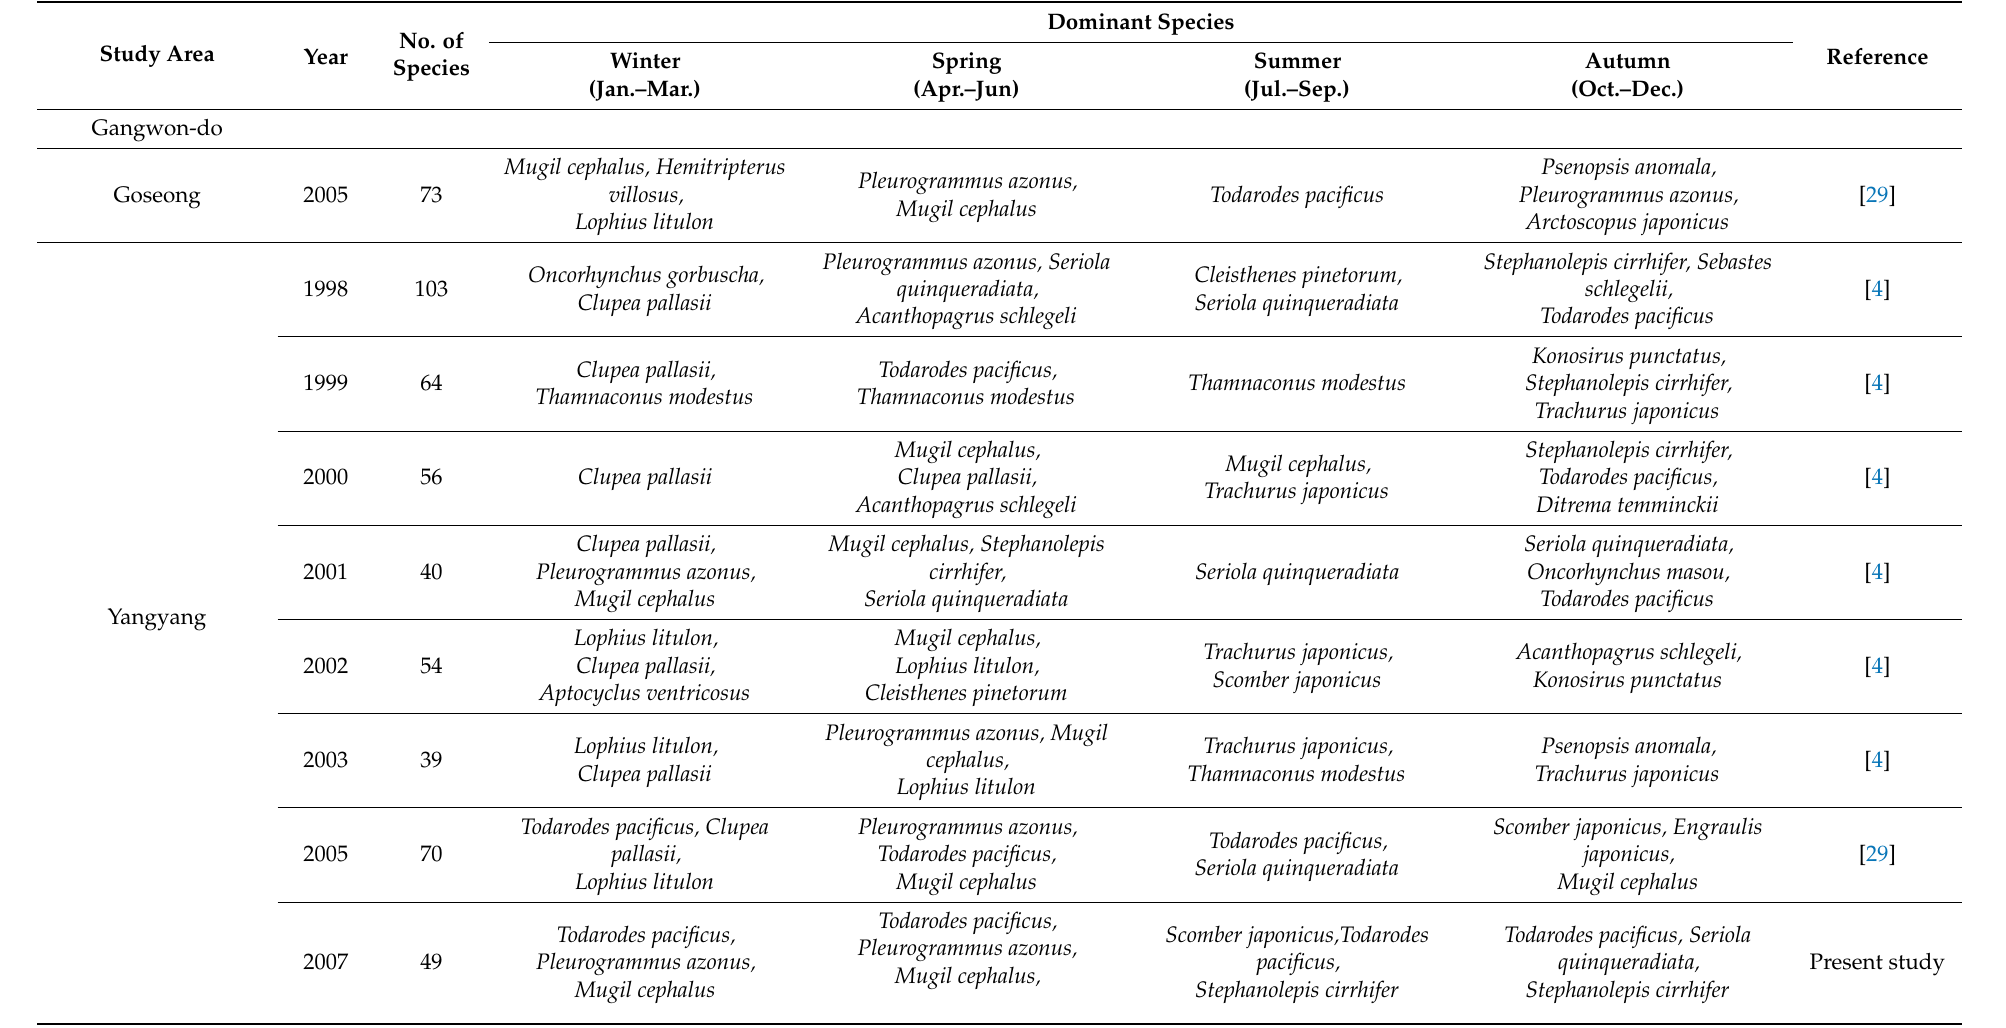
Table 2. Seasonal variations of the dominant species of fishes captured in set nets from the East Sea of